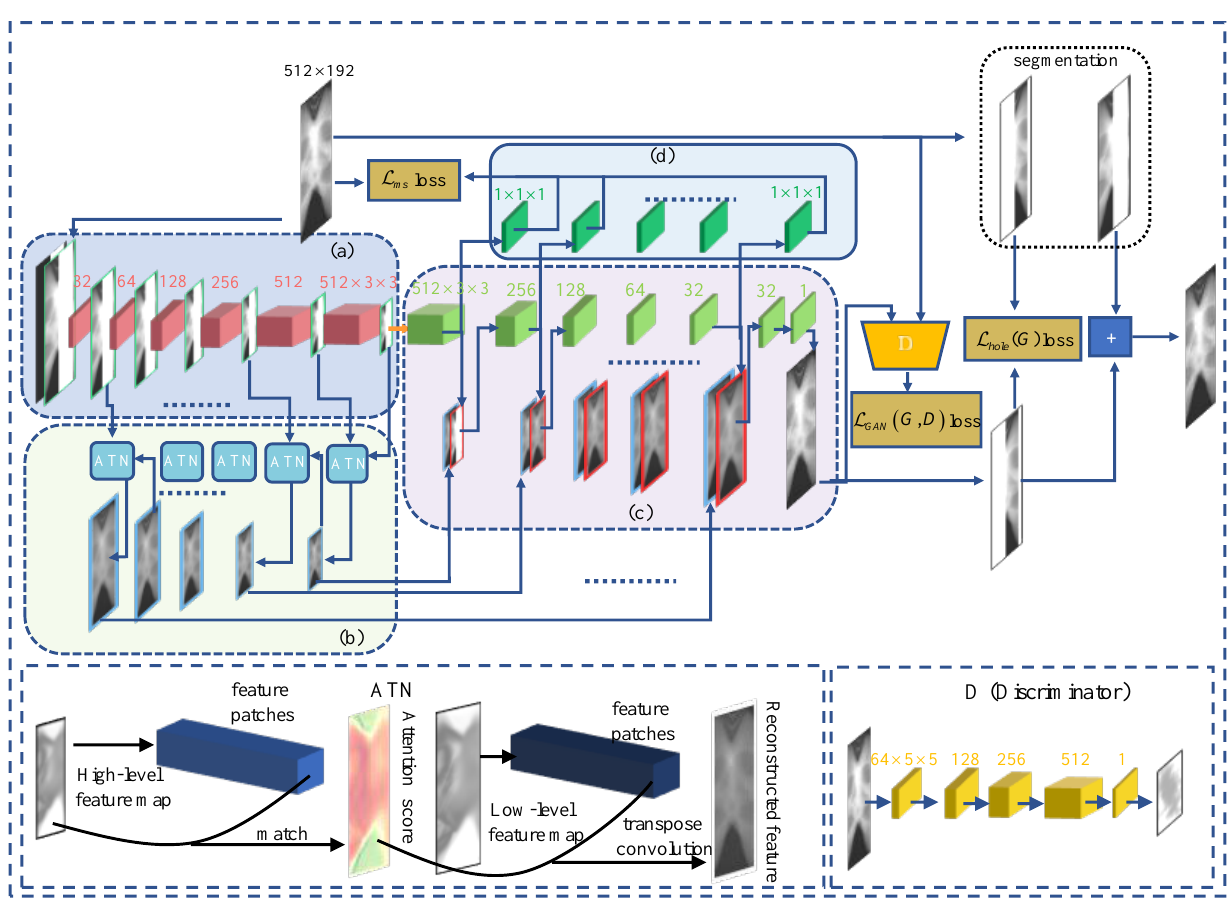
Figure 2. A diagram of the SI-GAN network framework. The network consists of 5 modules: ( a ) encoder module, ( b ) attention module, ( c ) decoder module, ( d ) multi-scale decoding module, and D discriminator module.